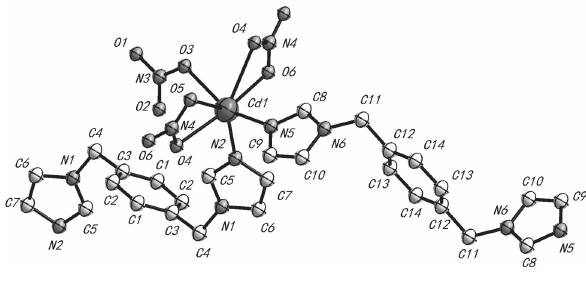
Table 1: Data collection and handling.